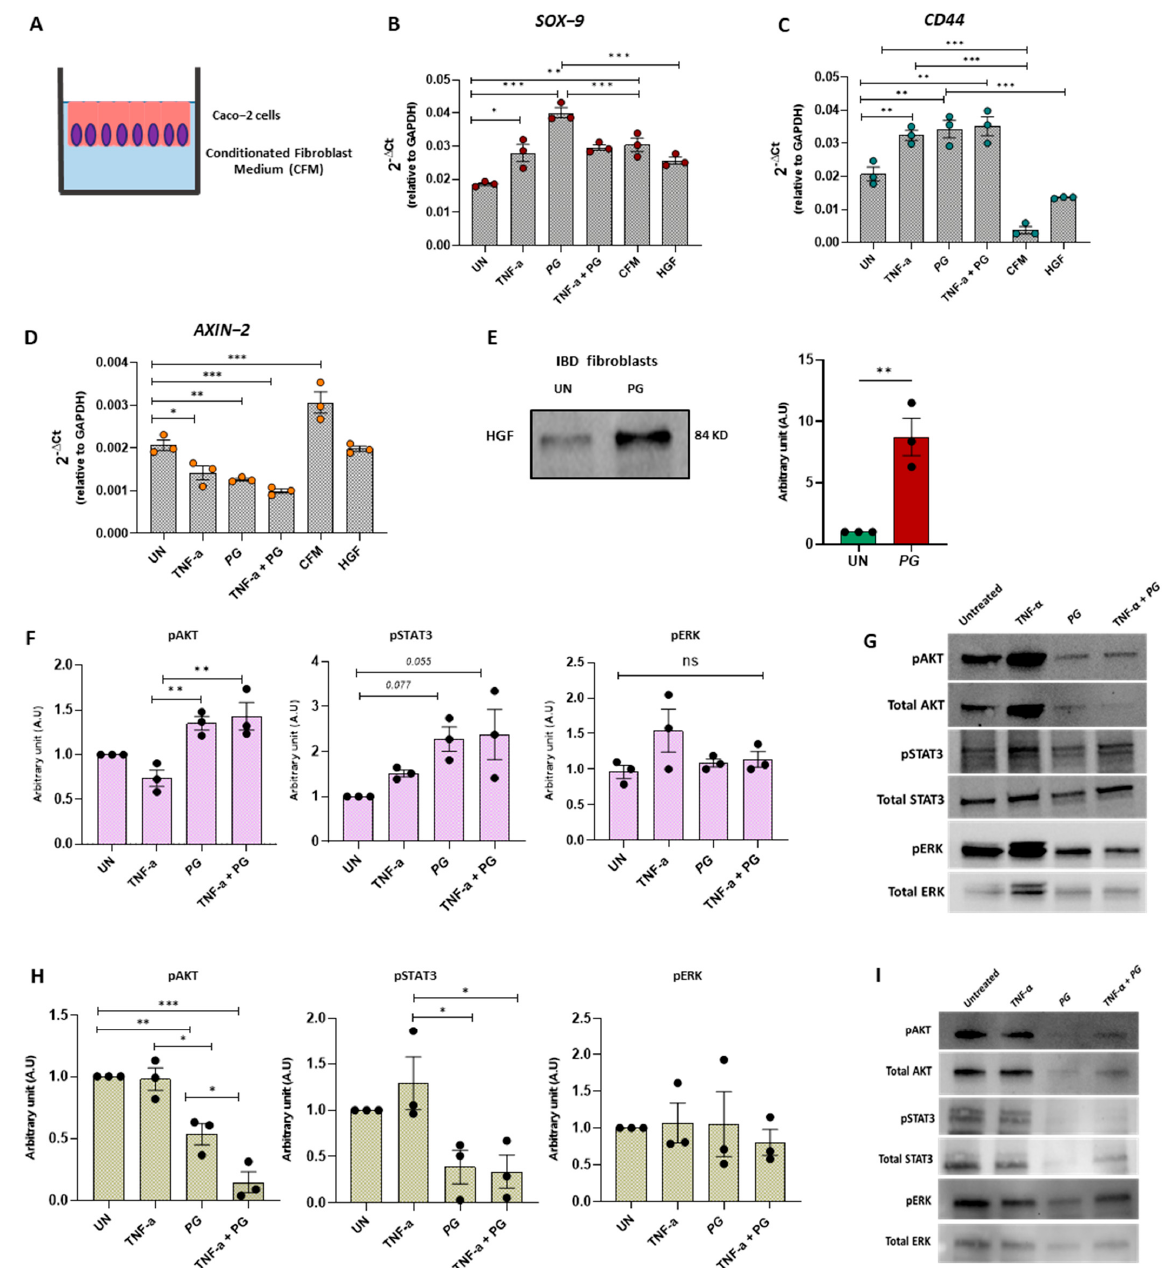
Figure 7. PG promoted intestinal epithelium repair by regulating fibroblast activity. ( A ) Experimental design of Caco − 2 cells cultured for 24 h with conditioned medium (CFM) derived from IBD fibroblasts stimulated ± TNF- α , PG , or TNF- α + PG . ( B − D ) Quantitative Real-Time PCR analysis of SOX − 9 , CD44 , and AXIN − 2 mRNA expression in Caco-2 cells treated ± TNF- α , PG , TNF- α + PG , CFM derived from fibroblasts stimulated with PG or HGF. Gene expression was normalized to GAPDH . ( E ) Western blot analysis of HGF in the supernatants of IBD fibroblasts ± PG . HGF was normalized on total proteins ( F , G ) Western blot analysis of pAKT, Total AKT, pSTAT3, Total STAT3, pERK, and Total ERK in Caco − 2 cells ± TNF- α , PG or TNF- α + PG . ( H , I ) Western blot analysis of pAKT, Total AKT, pSTAT3, Total STAT3, pERK, and Total ERK in IBD fibroblasts ± TNF- α , PG or TNF- α + PG . Phosphorylated AKT, STAT3 and ERK were normalized on total AKT, STAT3, and ERK, respectively. Data are presented as mean ± SEM. One-way ANOVA test. * p < 0.05, ** p < 0.01, *** p < 0.001. n =